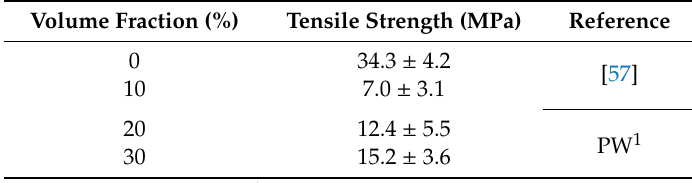
Table 5. Tensile strength results for the CM fiber-reinforced composites.